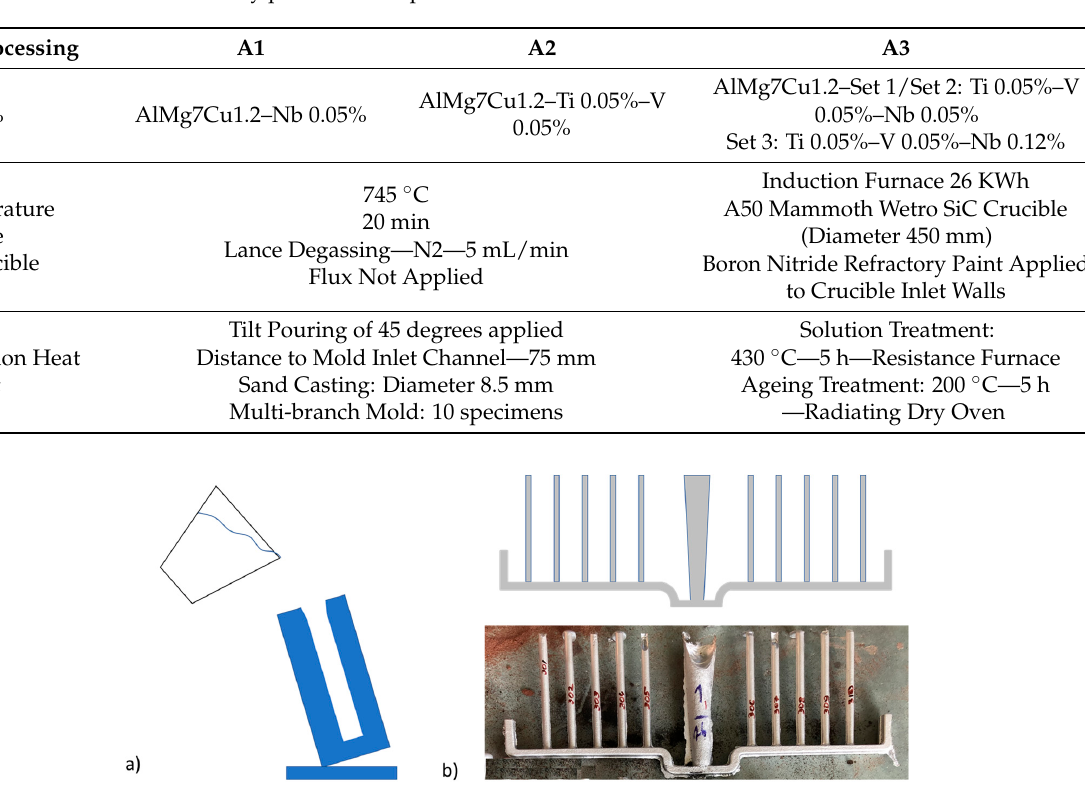
Table 1. Alloy production Experiment Parameters.